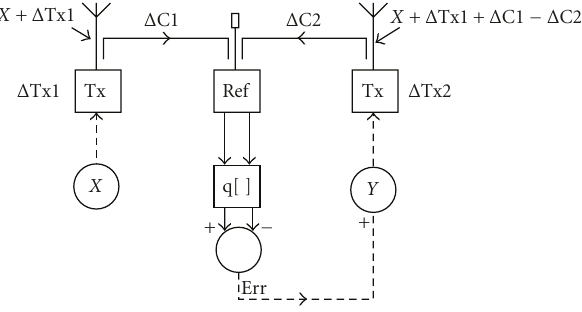
Figure 5: Propagation of error between calibrating